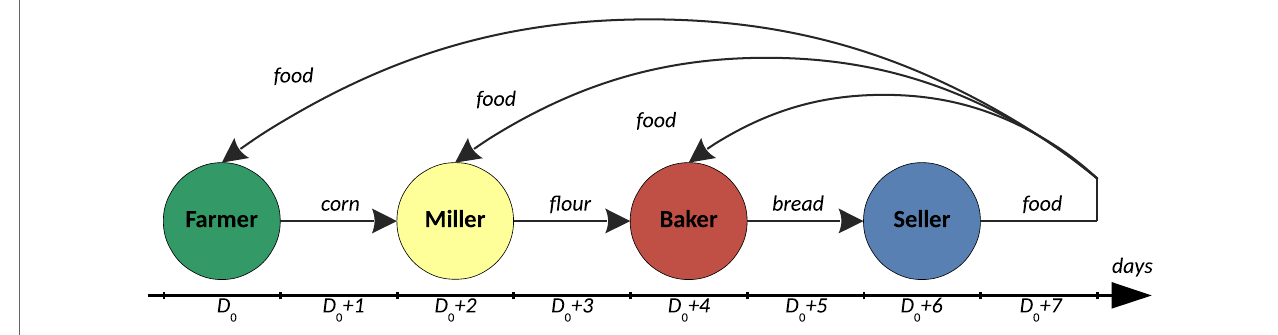
FigUre 9 | example of simplified time dependencies between entrepreneurs of different types during one food production cycle that starts on day D 0 .